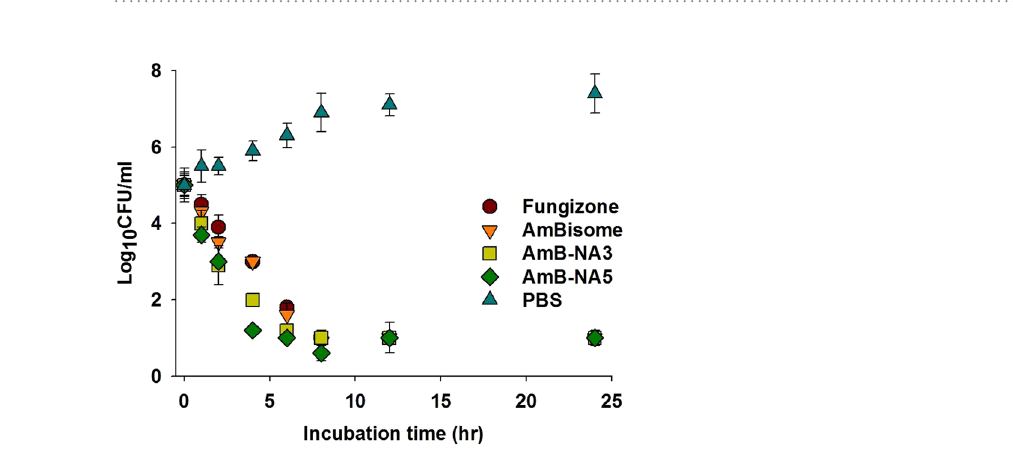
Figure 5. AmB-NA formulation demonstrated strong antifungal activity against fungal pathogen: ( A ) Representative time–kill curve plot for C . albicans in the presence of Fungizone, AmBisome or AmB-NA at 4 × MIC. Wells containing no antibiotic were taken as control. Assays were performed in triplicate. Each result is representative of at least three separate experiments. Values represent mean ±